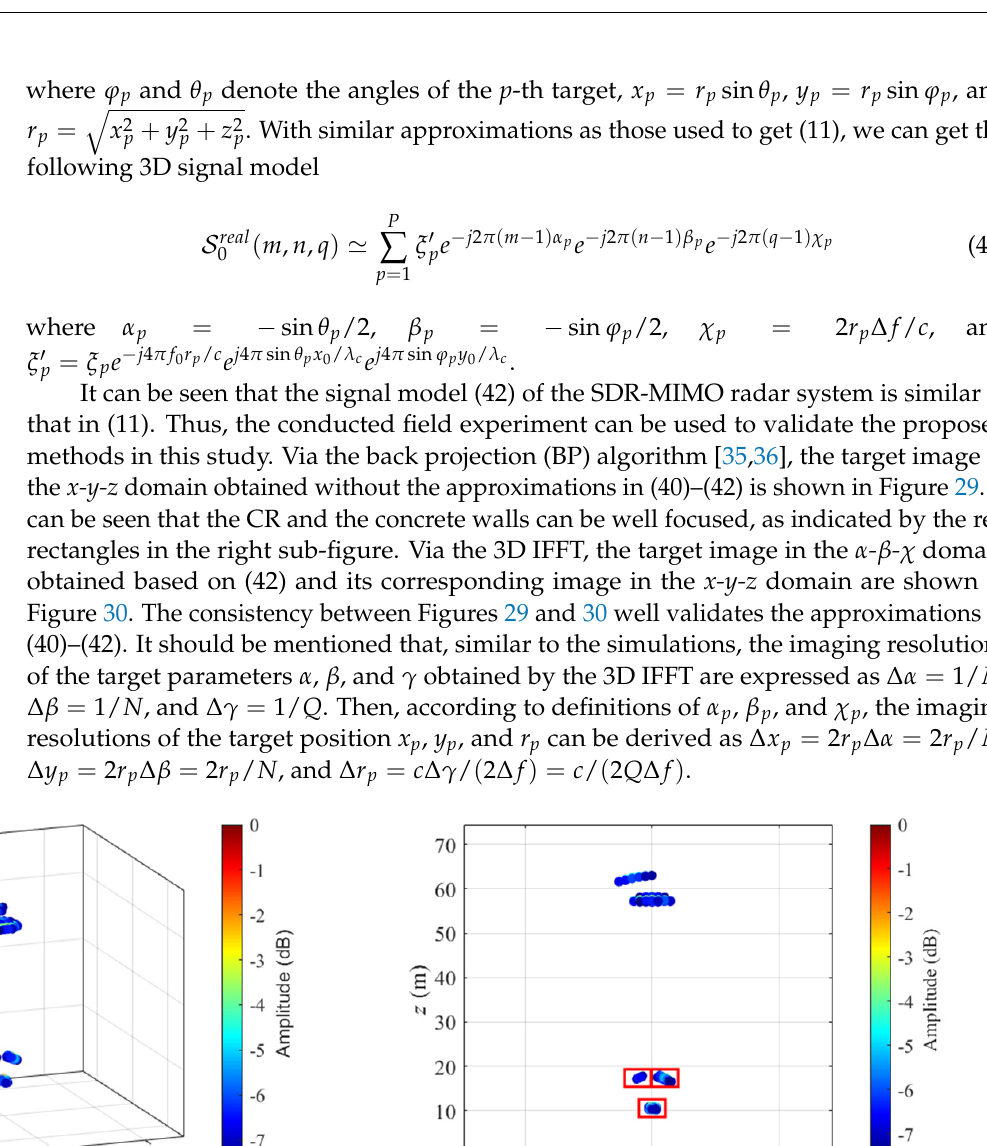
Figure 29. Real target imaging result obtained by the BP algorithm. The CR and the two close concrete walls are marked by the rectangles in the right sub-figure. The other two scatters indicate two concrete walls further from the radar system.